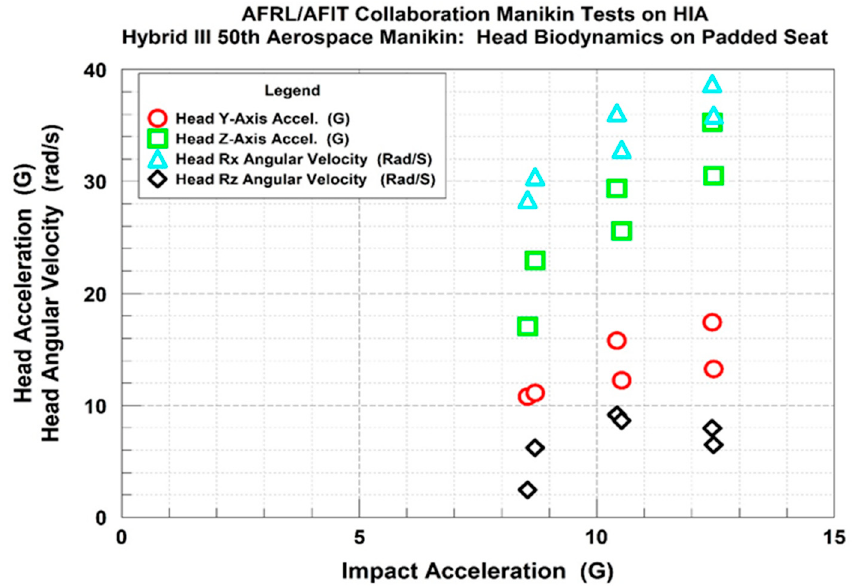
Figure 6. ATD head responses in the padded seat. The plot shows the trend for the head z -axis (axial) and head y -axis (lateral) linear accelerations, and the head rotational velocities around the x -axis and the z -axis, to increase linearly as a function of the impact acceleration. The axial acceleration (squares) was noticeably greater than the lateral acceleration (circles), and the rotational velocity around x -axis (triangles) was much greater than the velocity around the z -axis (diamonds).